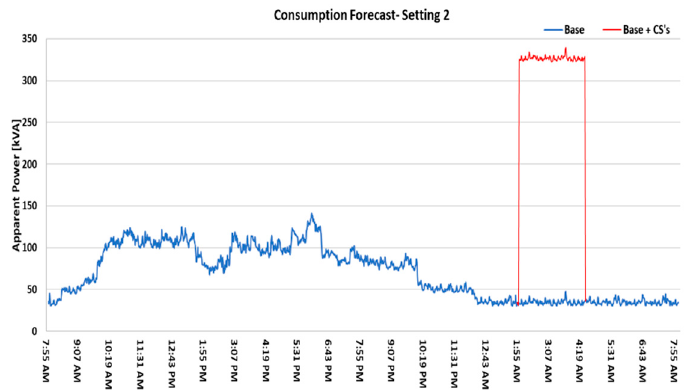
Figure 7. Consumption Forecast—Setting 2.